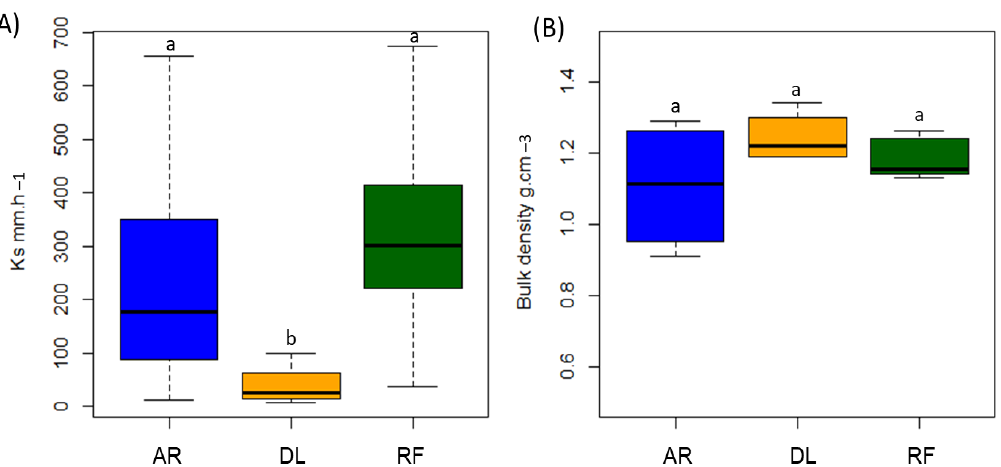
Figure 2. Boxplot of the ( A ) saturated soil hydraulic conductivity ( K s ) and ( B ) soil bulk density (g cm − 3 ) for each land cover type. AR, Active Restoration; DL, Degraded Land; RF, Reference Forest. Different letters represent significant differences at p <